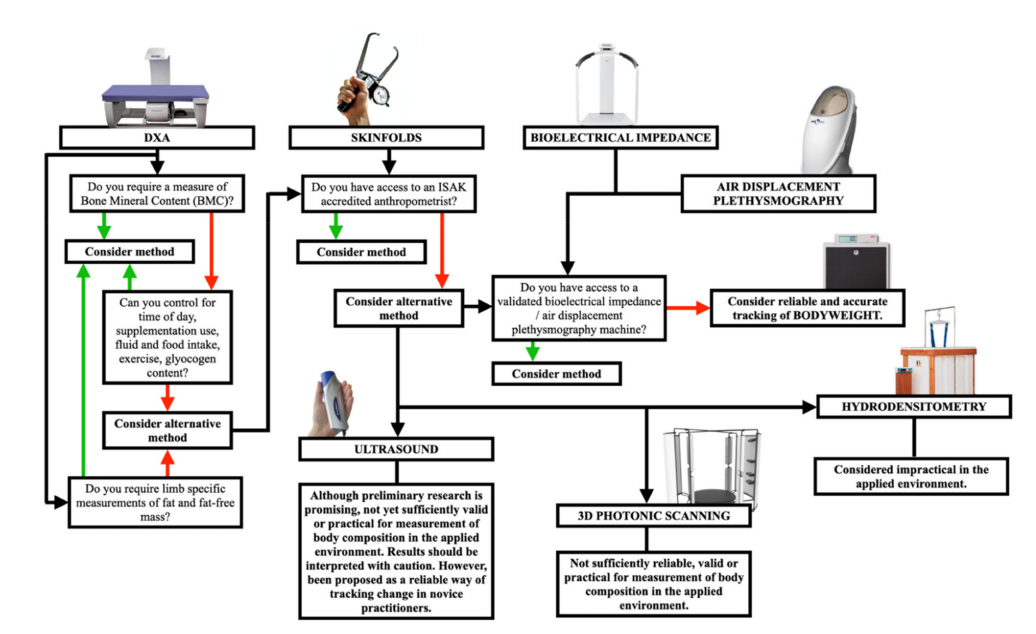
Figure 2. A proposed body composition method decision-making tree. Evidence base and applicability of all methods should be considered within the specific context in which they are being applied, be conducted by a suitably accredited/trained individual with all risks managed and should deliberate all points made throughout the current article prior to application of the chosen method. Green arrows indicate yes as the answer, red arrows indicate no as the answer, and black arrows indicate the potential flow of questioning when considering different methods of anthropometrical